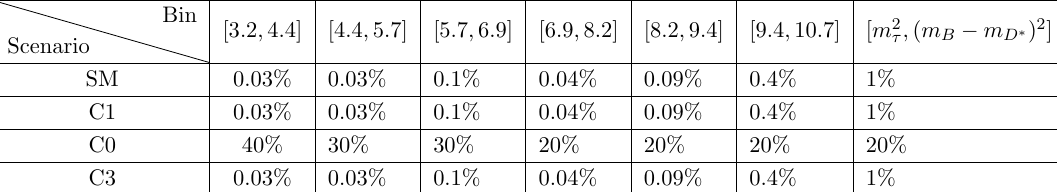
i (cid:28) with T